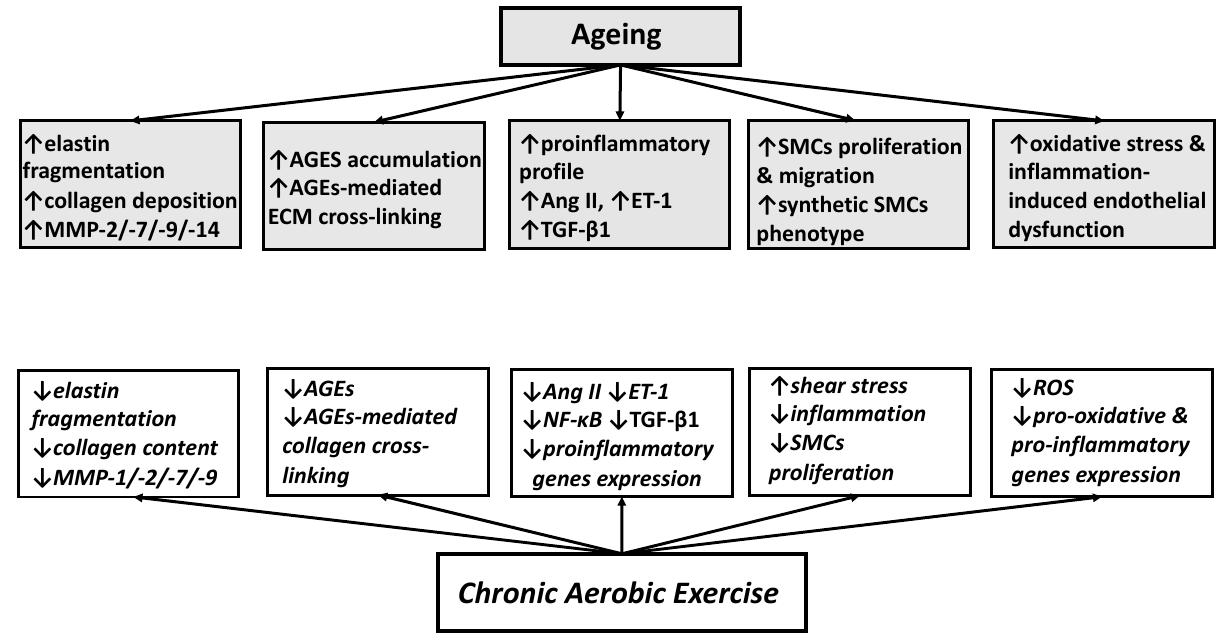
Figure 2. Mechanisms through which ageing deteriorates arterial compliance (grey rectangles) and mechanisms through which chronic aerobic exercise improves arterial compliance (white rectangles). MMP: matrix-metalloproteinase; AGEs: advanced glycation end products; Ang II: angiotensin II; ET-1: endothelin-1; NF- κ B: nuclear factor kappa-light-chain-enhancer of activated B cells; TGF- β 1: transforming growth factor- β 1; SMCs: smooth muscle cells; ROS: reactive oxygen species.